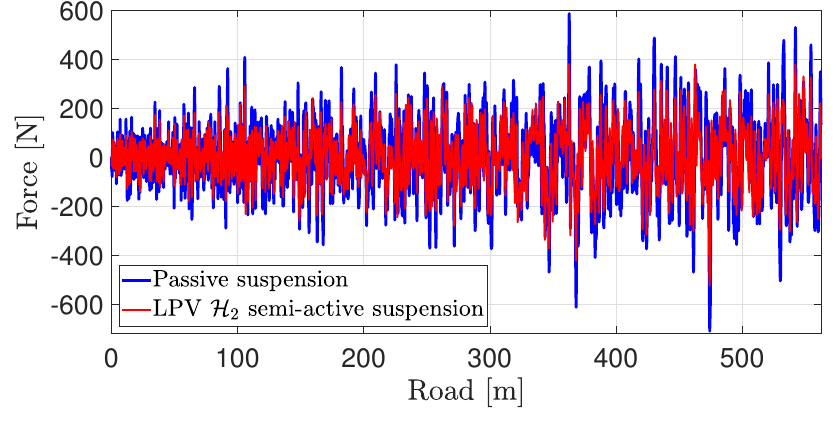
Figure 16. Damper force at the front right